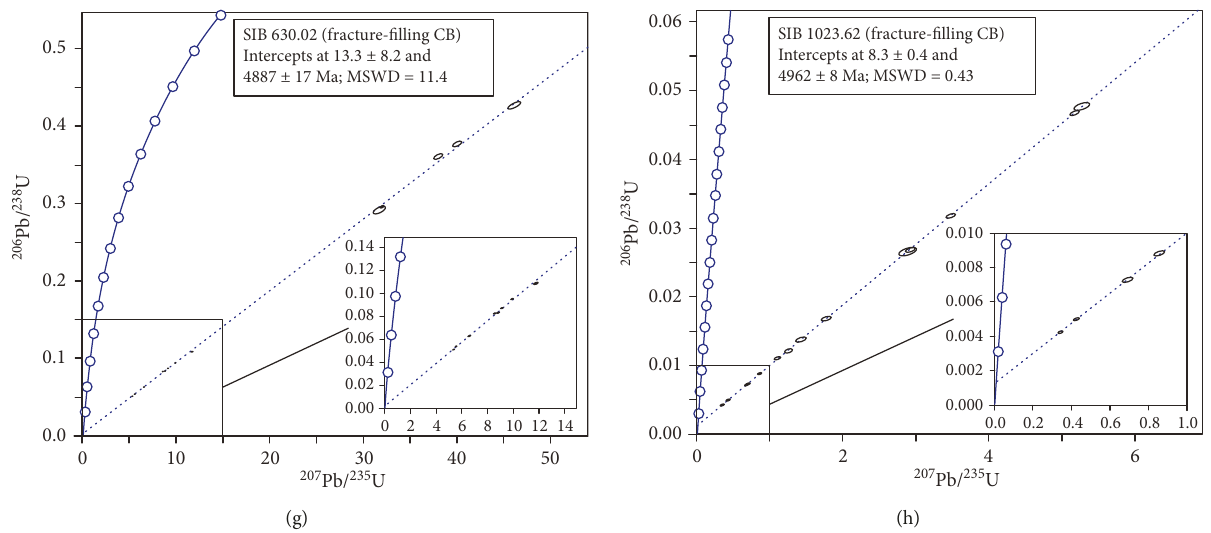
Figure 14: Wetherill concordia diagrams illustrating the results of the LA-ICP-MS analyses of secondary calcites in the Muschelkalk (MK) and the crystalline basement (CB) at the wells of Benken (BEN), Schlattingen (SLA), Siblingen (SIB), and Leuggern (LEU). The error ellipses correspond to two standard deviations of the